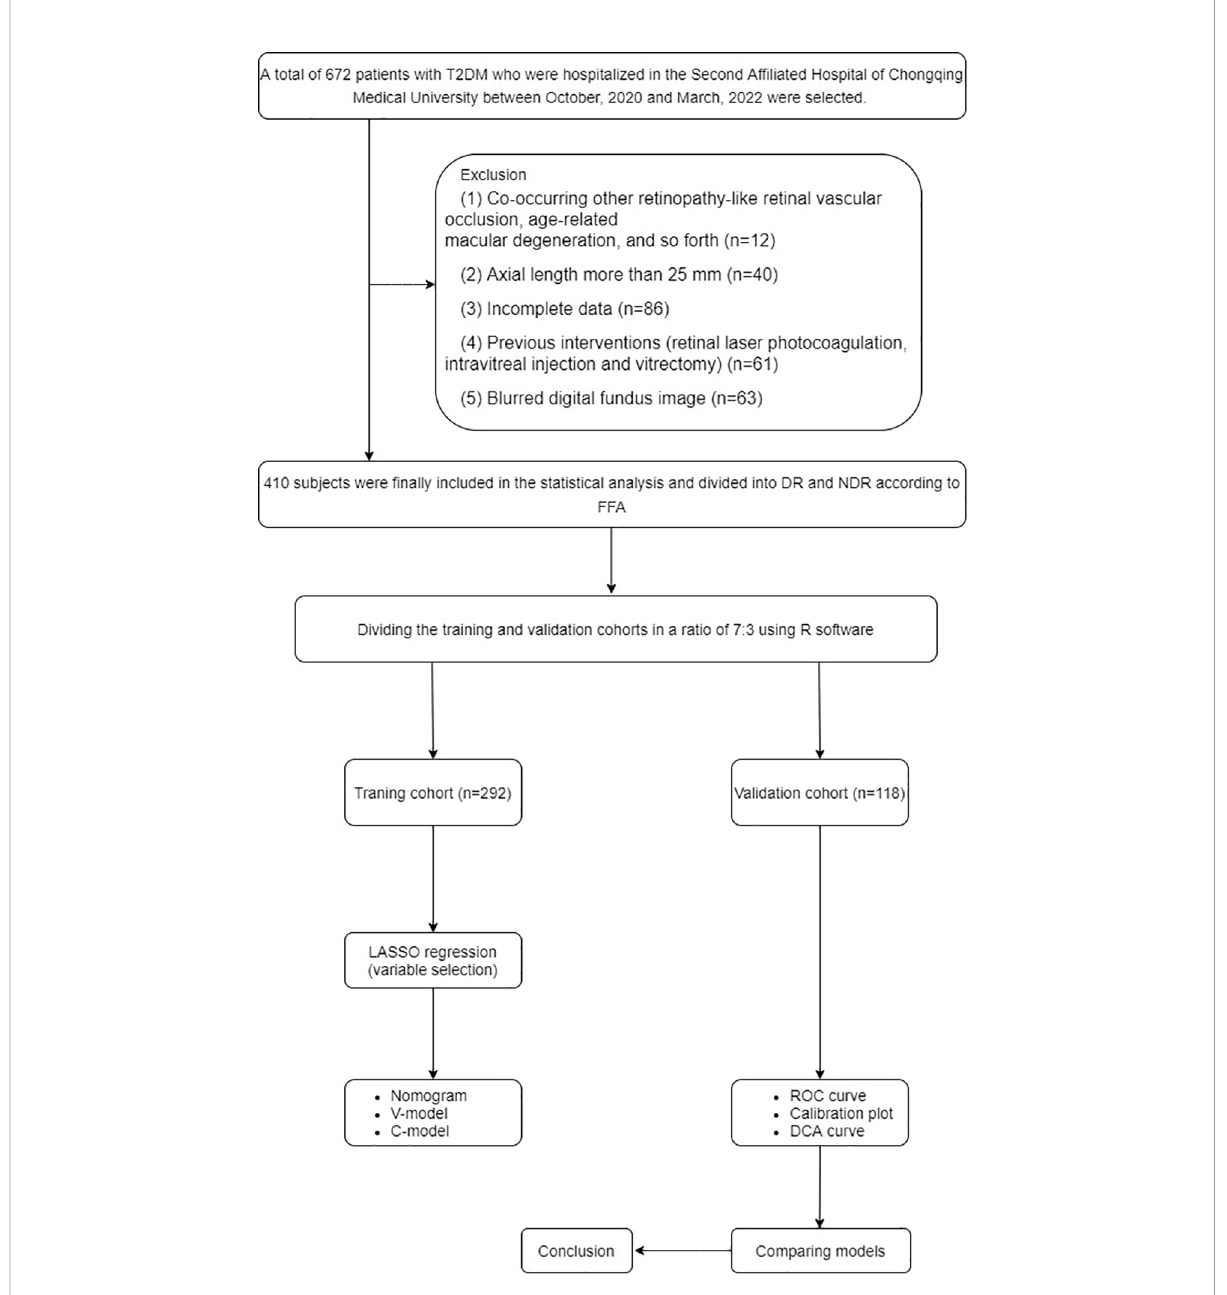
FIGURE 1 Flow diagram of the